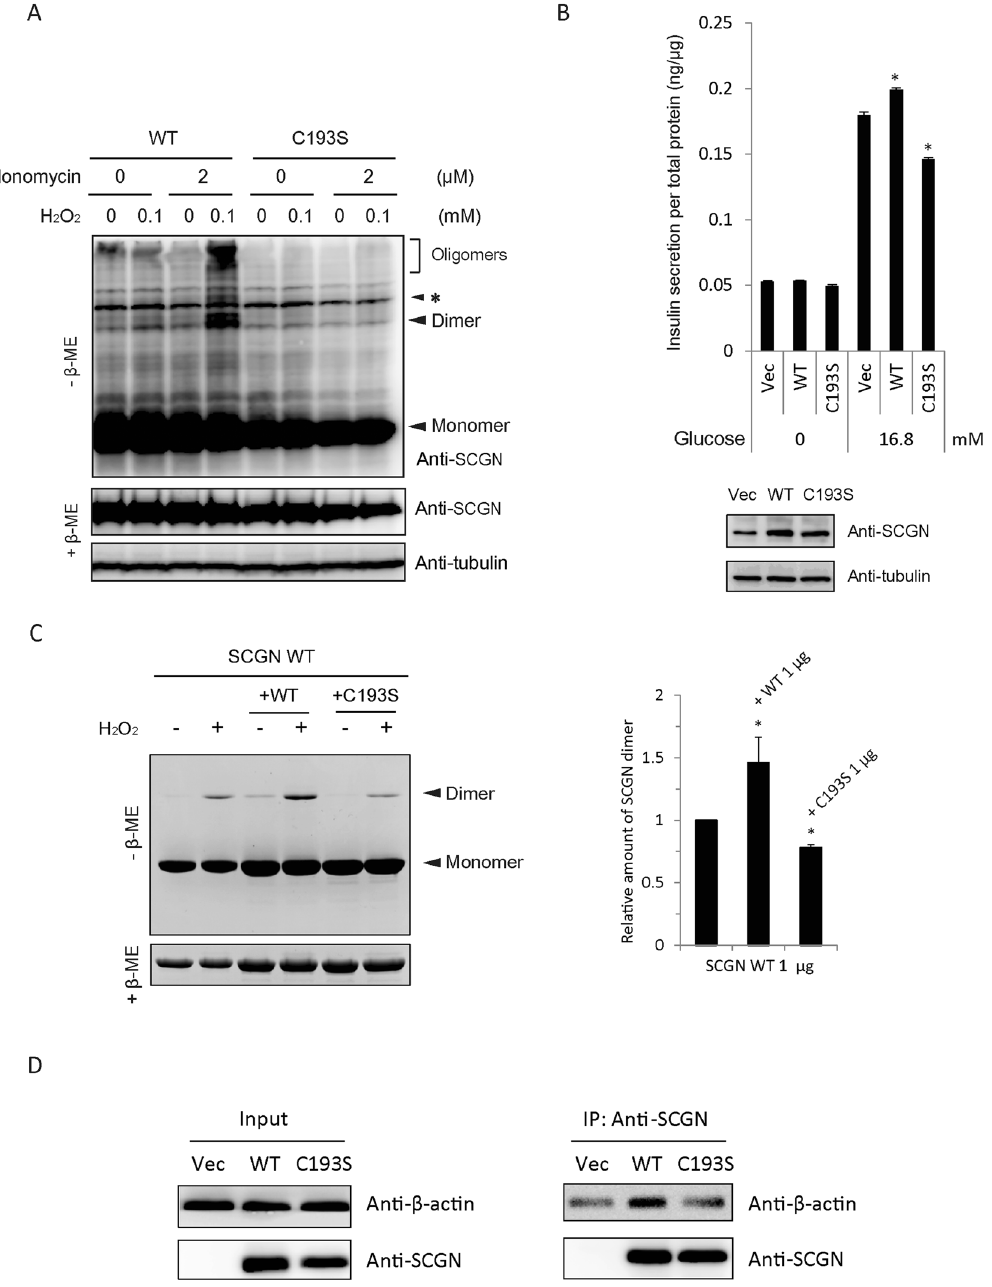
Figure 5. Dimerization of hSCGN is required for its role in insulin secretion. ( A ) NIT-1 insulinoma cells overexpressing hSCGN WT and C193S mutant were pre-incubated with 0 or 2 μ M ionomycin for 5 min followed by incubation with 0 or 100 μ M H 2 O 2 for 30 min at 37 °C. Proteins were separated under non-reducing and reducing conditions on SDS PAGE and detected with Western analysis using anti-SCGN antibody. Non-specific bands were indicated as * . ( B ) NIT-1 cells overexpressing hSCGN WT or C193S mutant were starved with glucose- free HBSS for 2 h followed by stimulation with 16.8 mM glucose for 25 min. The amount of secreted insulin was measured and normalized to total cell protein concentration. Whole cell lysates were subjected to Western analysis with anti-SCGN or anti- α -tubulin antibody. ( C ) Dimer formations of hSCGN WT, and hSCGN WT mixed with same amount of hSCGN WT or C193S proteins were measured after treating with 2 mM CaCl 2 for 15 min at R.T. followed by incubation with 0 or 1 mM H 2 O 2 for 1 h at 37°C. Proteins were detected with coomassie blue-staining (left panel) and were quantified and normalized with reduced form of SCGN (right panel). ( D ) hSCGN C193S fails to interact with cytoskeletal actin in MDA-MB-231 cells. MDA-MB-231 cells overexpressing SCGN WT and C193S mutant were lysed with a lysis buffer containing protease inhibitors. Cell lysates were immunoprecipitated with anti-SCGN antibody and the immune complexes were separated on SDS-PAGE and detected with western analysis using anti-actin and anti-SCGN antibodies. Data information: In ( B , C ), data are expressed as the mean ± SD of three experiments ( * P < 0.05, Student’s t-test). Full-length gels and blots are presented in Supplementary Fig.